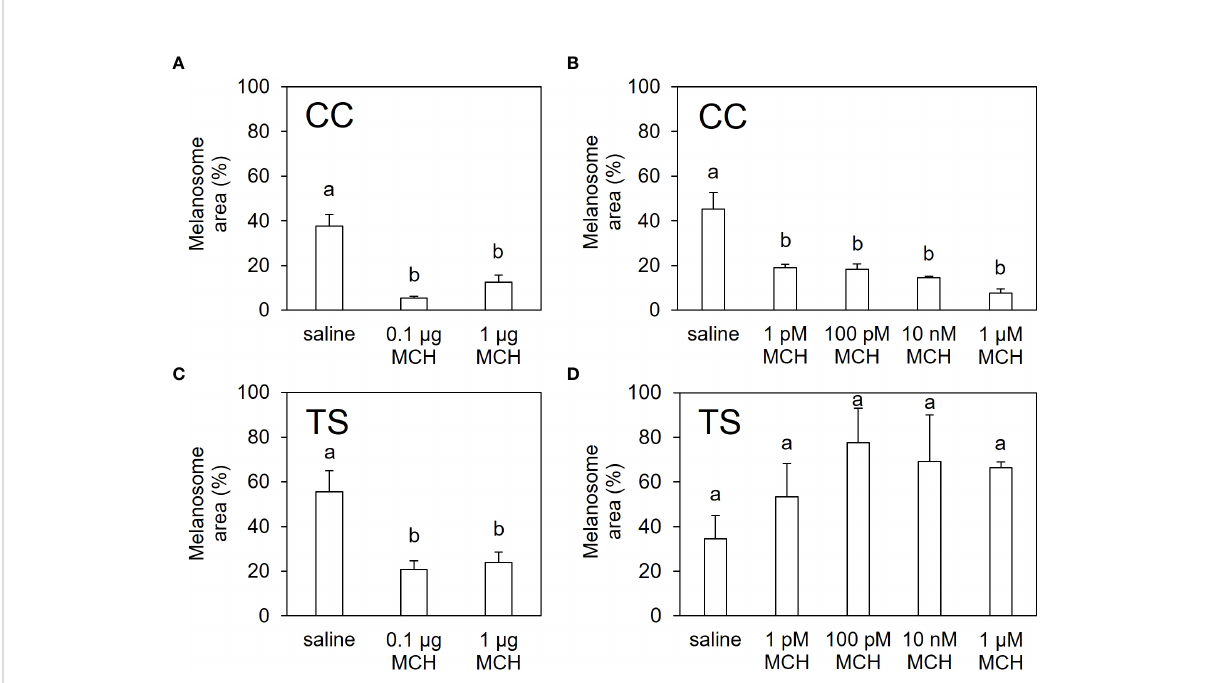
FIGURE 5 In vitro and ex vivo pigment-aggregating effects of MCH. Extent of melanosome area in the scales of CC (A, B) and TS (C, D) injected intraperitoneally with MCH (A, C) or treated with MCH ex vivo (B, D) . Data are shown as mean ± SE. Different letters indicate statistically signi fi cant differences estimated by one-way analysis of variance (ANOVA) followed by Tukey ’ s honestly signi fi cant difference (HSD) test; P < 0.05, n = 6 for (A) and (C) , n = 3 for (B) and (D)